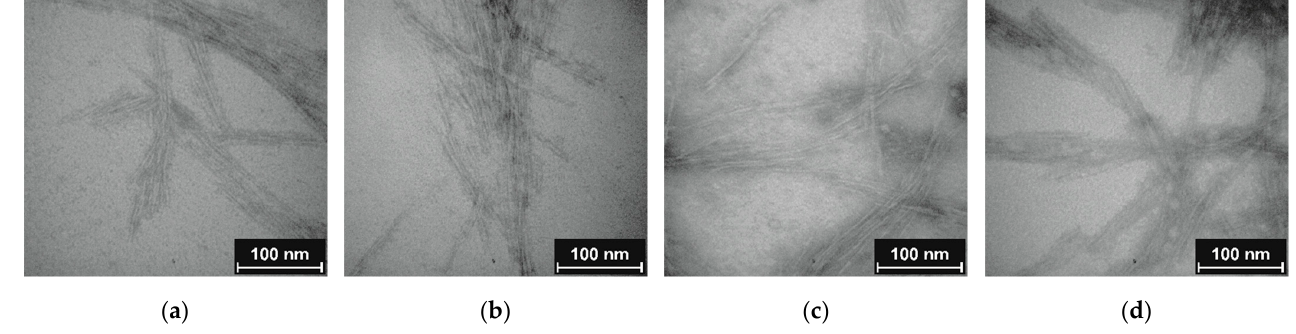
Figure 5. TEM image ( a ) non-modified CNC; ( b ) CNC-APTES-3; ( c ) CNC-APTES-FITC-3; ( d ) CNC-